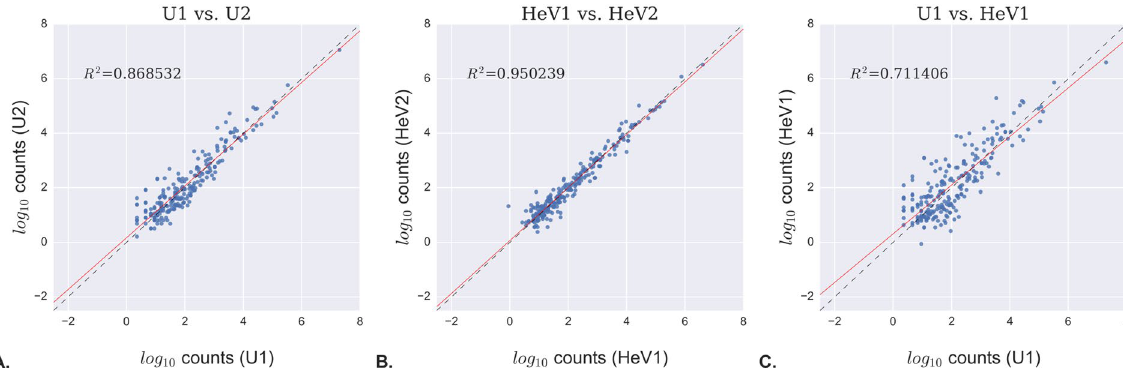
Figure 4. Representative inter-sample comparisons at the single-miRNA level. ( A ) Uninfected horse #1 vs. uninfected horse #2. ( B ) Infected horse #1 vs. infected horse #2. ( C ) Uninfected horse #1 vs. infected horse #1. Points represent DESeq2-normalized read counts for each miRNA and are drawn in log 10 scale on both axes. The midline ( ‐‐‐ ) illustrates optimal correlation (i.e. points that fall on this line have equal expression in both samples). In contrast, points that lie further from the midline represent between-sample variation for individual miRNAs. R 2 values reflect the overall correlation between samples, while the line of best fit (red line) was determined using linear least-squares